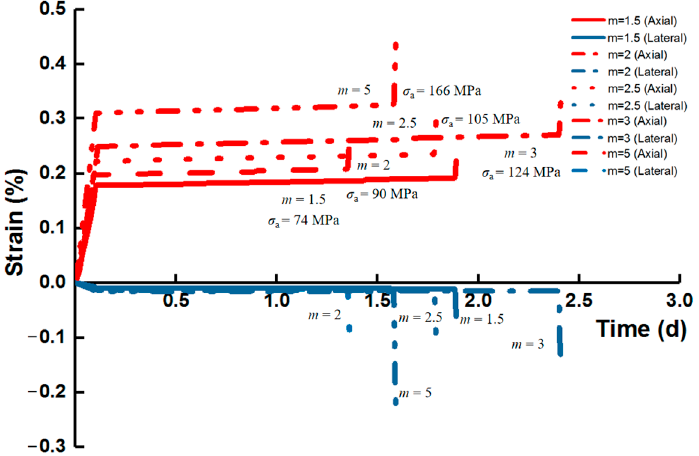
Figure 7. Behavior of creep strain at the last stress level for various homogeneity indexes during uniaxial creep loading.